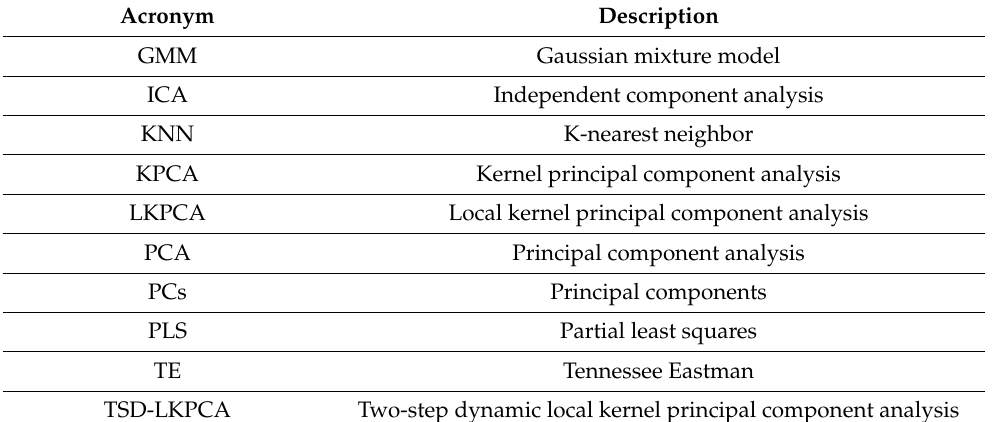
Table 2. Acronyms used in the present